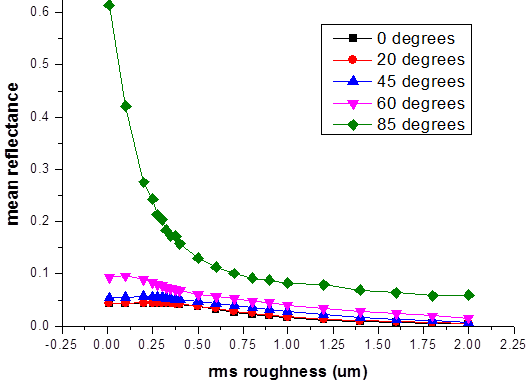
Figure 2. Simulated mean hemispherical reflectance for a PMMA surface with varying surface roughness and fixed autocorrelation length (1 μm). The 590 nanometer incident radiation impinges on the surface at angles ranging from 0° to 85° relative to the global surface